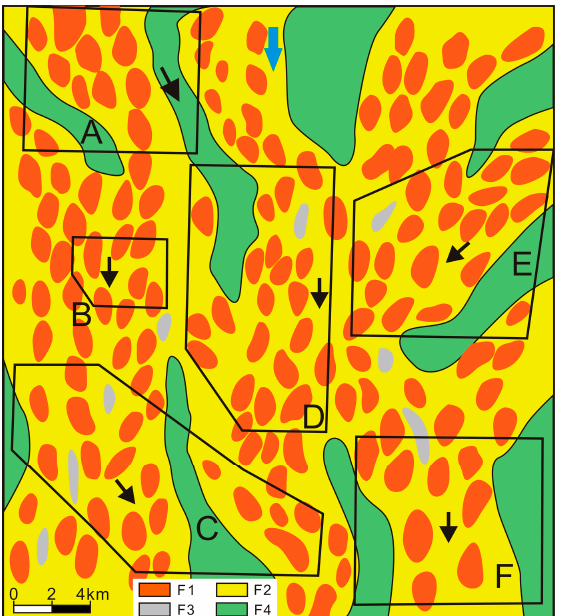
Figure 5. Different types of sand bodies and mudstone distribution trends of the subdivided zones. The different trends are indicated by six black arrows and the blue arrow refers to the general source direction of the study area. F1 and F2 refer to the sandy facies, F3 and F4 refer to the muddy facies.